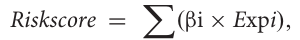
Supplementary Table 1 . The cBio Cancer Genomics